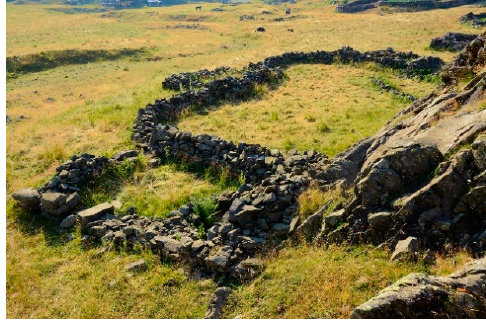
Figure 33. Sheep corral ( torina) built in drystone - Bušat photo: I. Lakovi ć .